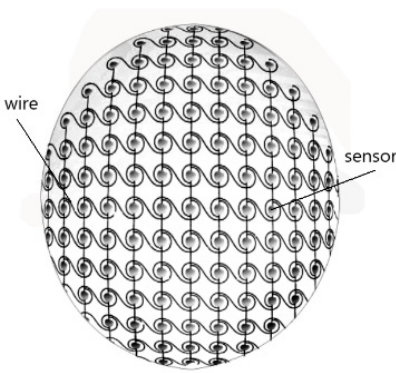
Figure 6. Sensor and wire layout using the Conic Equidistance Method.